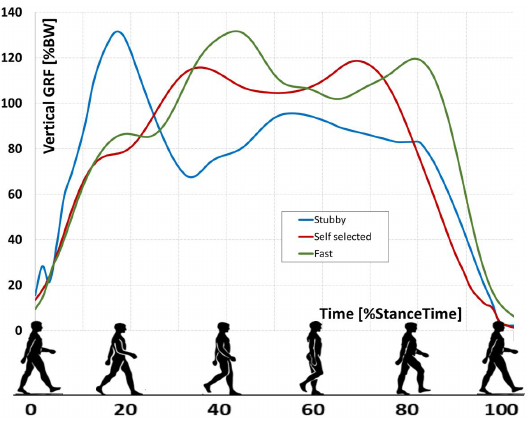
Figure 2. Vertical ground reaction force (vGRF) in three analyzed gaits. 4. Discussion The general health status and the state of the stump have an effect on the correctness and efficiency of the gait after a double transfemoral amputation [21]. The properly hardened stump allows for the painless axial load to which it is subjected in the prosthe- sis funnel. A particularly important element is also the fitting of a prosthesis funnel and full mobility of the hip joint. In many people who have undergone double amputation, flexion-abduction contractures are observed in the hip joint. These contractures can sig- nificantly limit the learning of proper gait. A multi-stage rehabilitation process, main- taining normal movement ranges and scar treatment means that the time of actually learning to walk with a prosthesis is sometimes reduced. In addition, the fear of falling and the ability to find oneself in a different situation can prolong the prosthesis fitting process. The first step in improvement is changing position—from a sitting position to a standing one. In many cases, this stage is difficult to achieve due to a fear of falling. Stubby prostheses (stubbies) ensure gradual adaptation to the use of standard prostheses by lowering the center of body mass, which improves coordination and balance. The current limb prosthesis market offers a whole range of products tailored to the patient’s needs. Advances in prosthetics are centered around improved materials and designs that increase the performance of a given prosthesis and improve mobility, and a gait analysis makes it possible to create a product that will successfully reproduce a physiological gait. The definite advantage of using stubbies is the reduction of the center of body mass. This allows many people who have had a double amputation above the knee joints to be more active. This concerns both home activities as well as outdoor ones. In this case study, the pelvis and trunk were bent while the cadence had to be increased to maintain gait speed. In their research on people have had a double amputation, Carroll et al. also observed a higher cadence than in non-disabled participants (107.7 ± 14.0 step/min for the users of stubby prostheses and 104.4 ± 8.0 step/min for the users of full-length prostheses) [15]. In the studies by Jarvis et al., the cadence in people who have had a double ampu- tation was lower than in both participants who had had a unilateral amputation above the knee joint and in non-disabled people, where it was 96 step/min [14]. However, it should be noted that in this group the reason for the amputation was an improvised ex-